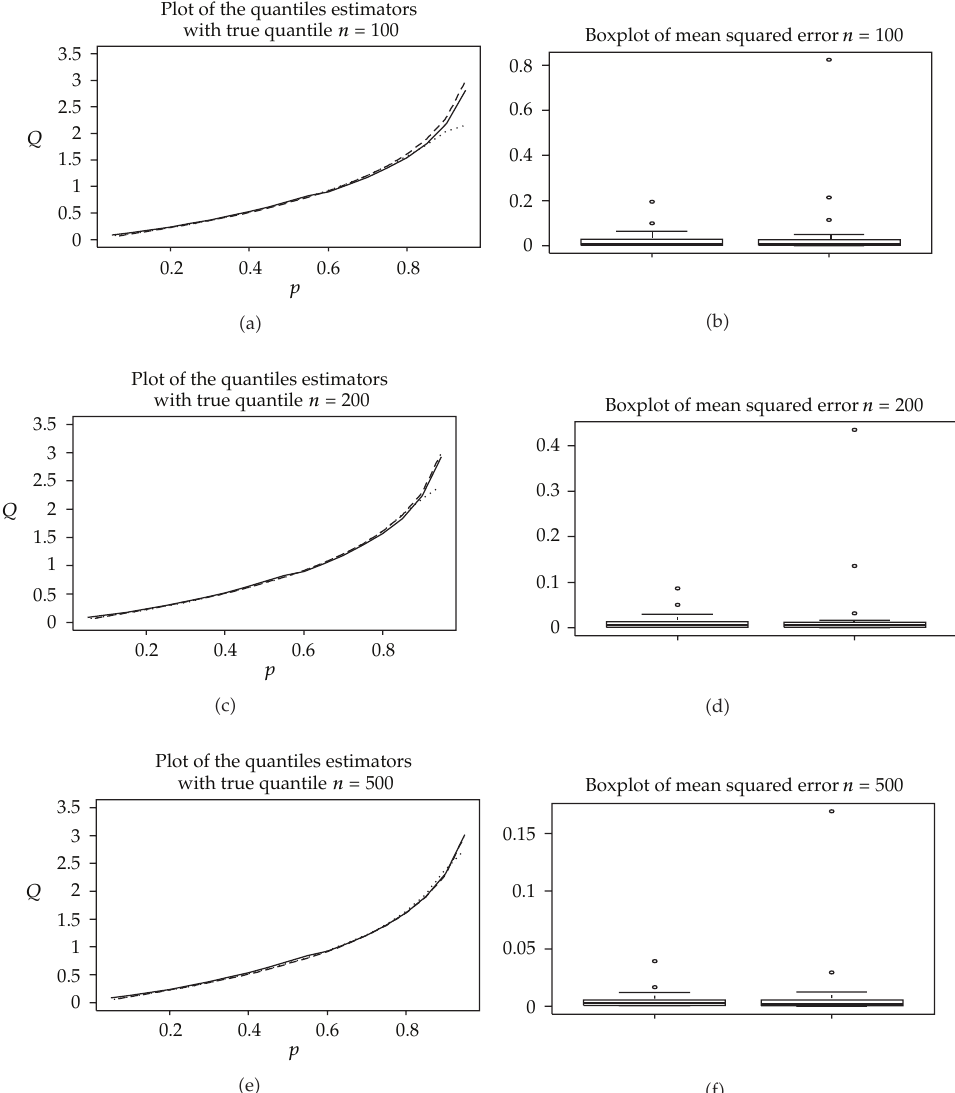
Figure 2: Left panel: plots of the quantile estimators for method 1 (cid:4) solid line (cid:5) , method 2 (cid:4) dotted line (cid:5) and true quantile (cid:4) dashed line (cid:5) for di ff erent sample sizes and for data from an exponential distribution. Right panel: box plots of mean squared errors for the quantile estimators for method 1 and method 2 for di ff erent sample